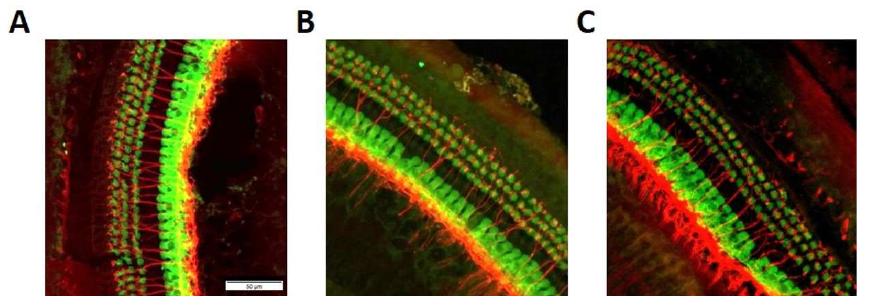
Figure 6. Whole mount staining of the organ of Corti in the basal turn after noise exposure of a wildtype mouse ( A ) a Coch −/− mouse ( B ) and a control mouse that was not exposed to noise ( C ). No structural damage of hair cells (anti-Myosin VIIa, green) or neurons and synapses (anti- synaptophysin, red) was observed in both groups.